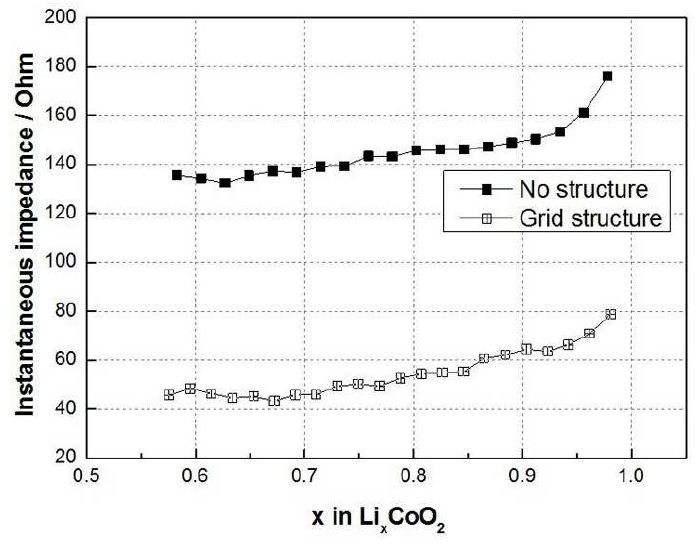
Figure 7. Instantaneous impedance as a function of lithium stoichiometry in the cathode.